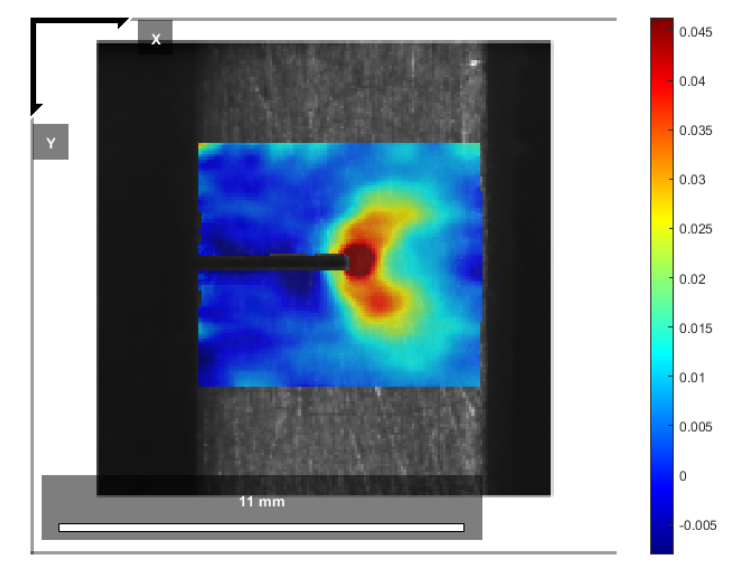
Figure 7. Proof of concept of obtained strains on filtered images in the form of vertical strain (cid:101) yy . The resolution is poor due to the large subset radius used, which is clearly seen from the large circle of maximal strain at the notch